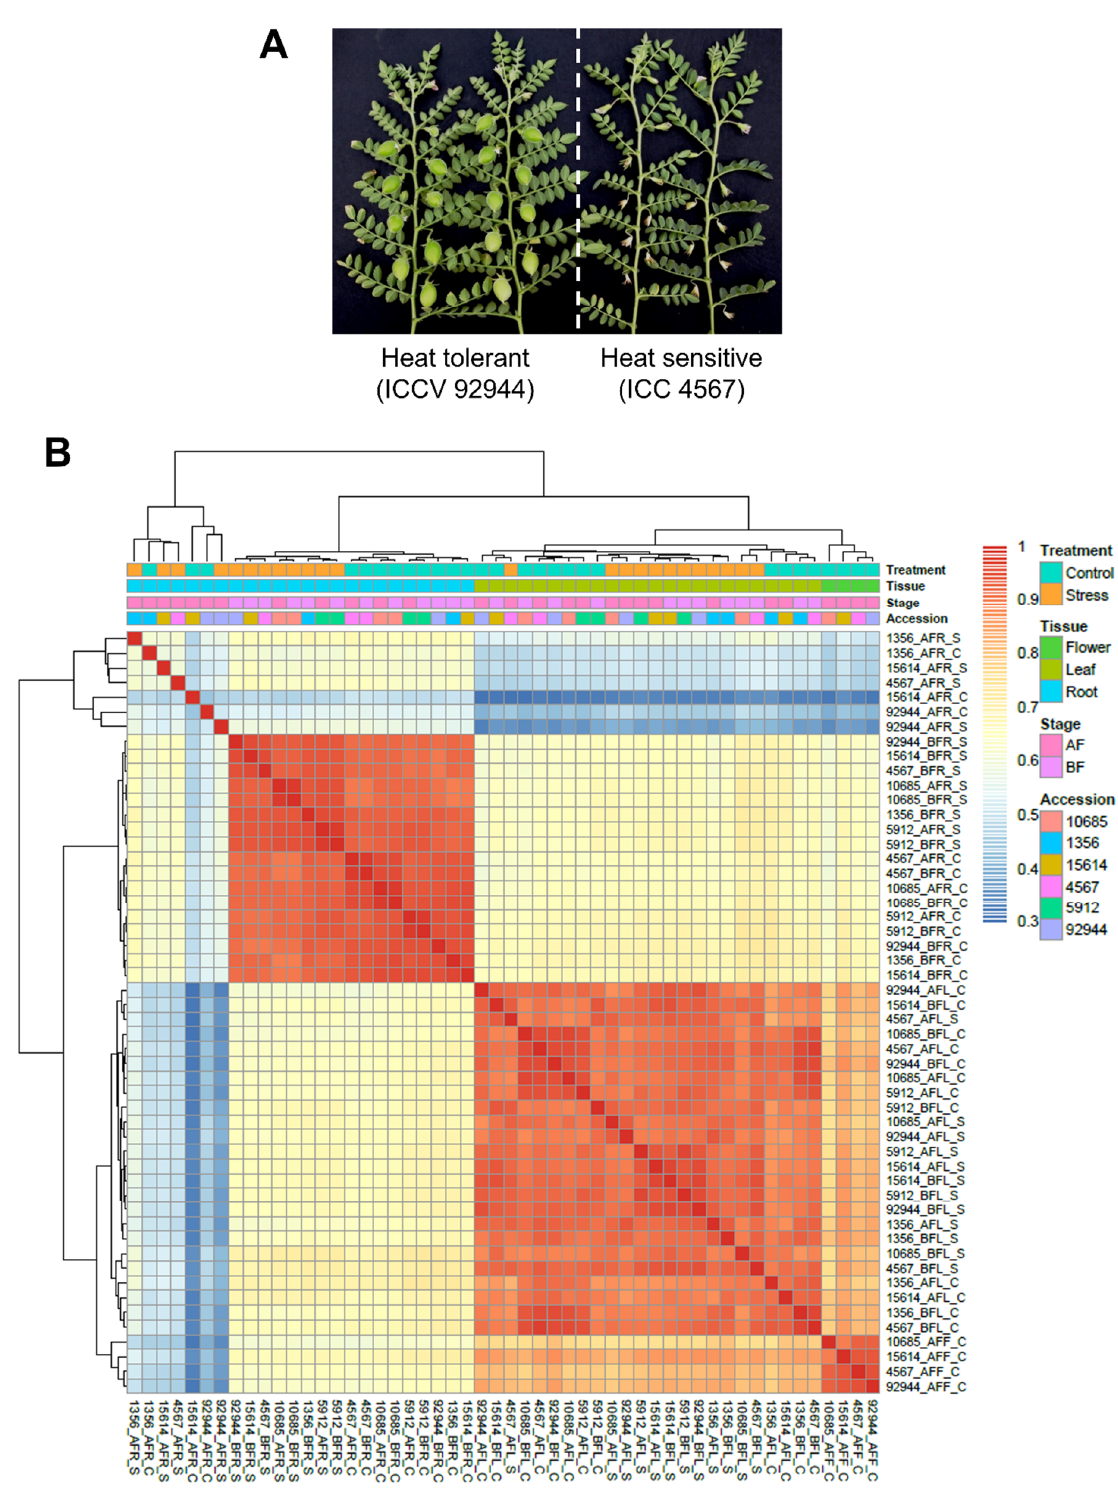
Figure 2. Global transcriptome analysis of 48 samples from six contrasting heat stress-responsive chickpea genotypes. ( A ) Plant phenotype of chickpea heat-tolerant (ICCV 92944) and -sensitive (ICC 4567) genotypes in response to heat stress. ( B ) Heatmap for the transcriptome profiling has been shown based on the hierarchical clustering of Pearson’s correlations ( R ) for the 48 samples. The color scale indicates the degree of correlation. Samples were clustered based on their pairwise correlations. Genes with a normalized expression level FPKM ≥ 1 in at least one of the 48 samples analyzed were designated as expressed and shown in the